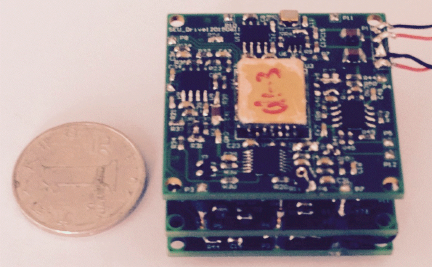
Figure 13. Prototype of DDMG.